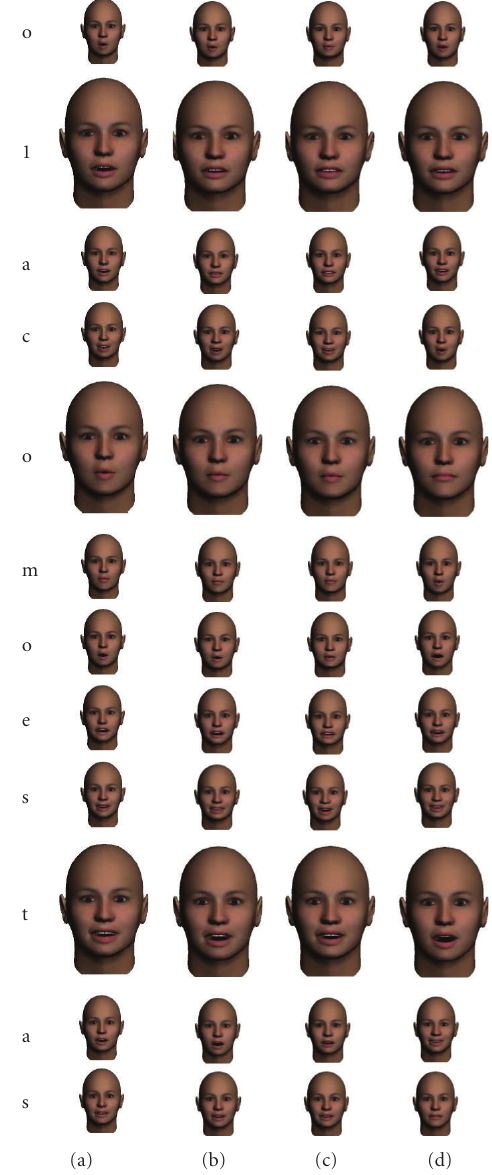
Figure 6: Face positions for the sentence “hola, c´omo estas?”: (a) targets are met (global constraint 0.03); (b) targets not met (global constraint 0.004); (c) targets not met (global constraint 0.002) and range constraints relaxed; (d) speaking slowly and targets not met (global constraint